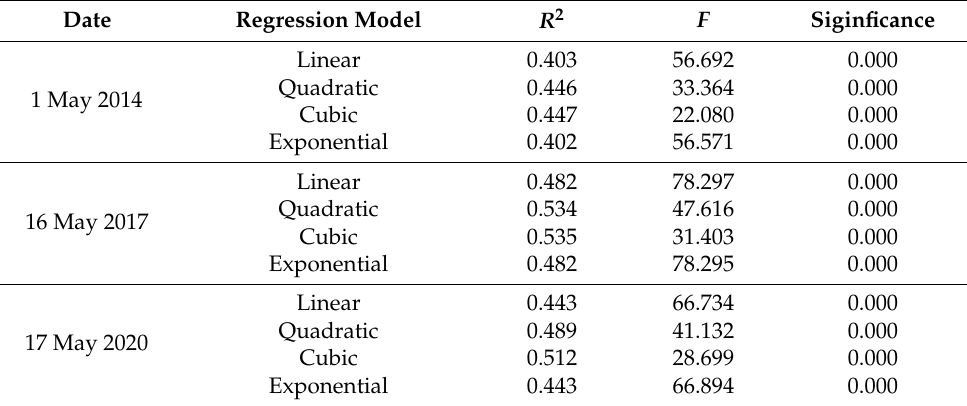
Figure 6. The inversed component fraction validation using a GF-1 image (taking the inversed vegetation and IPS fractions of 17 May 2020 as an example).